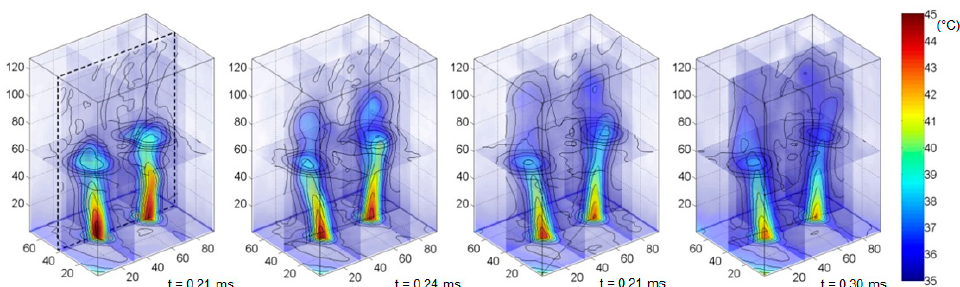
Figure 8. A tomographically reconstructed 3D temperature field of SJ, measured over different times. The period of SJ was set to τ = 125 ms.